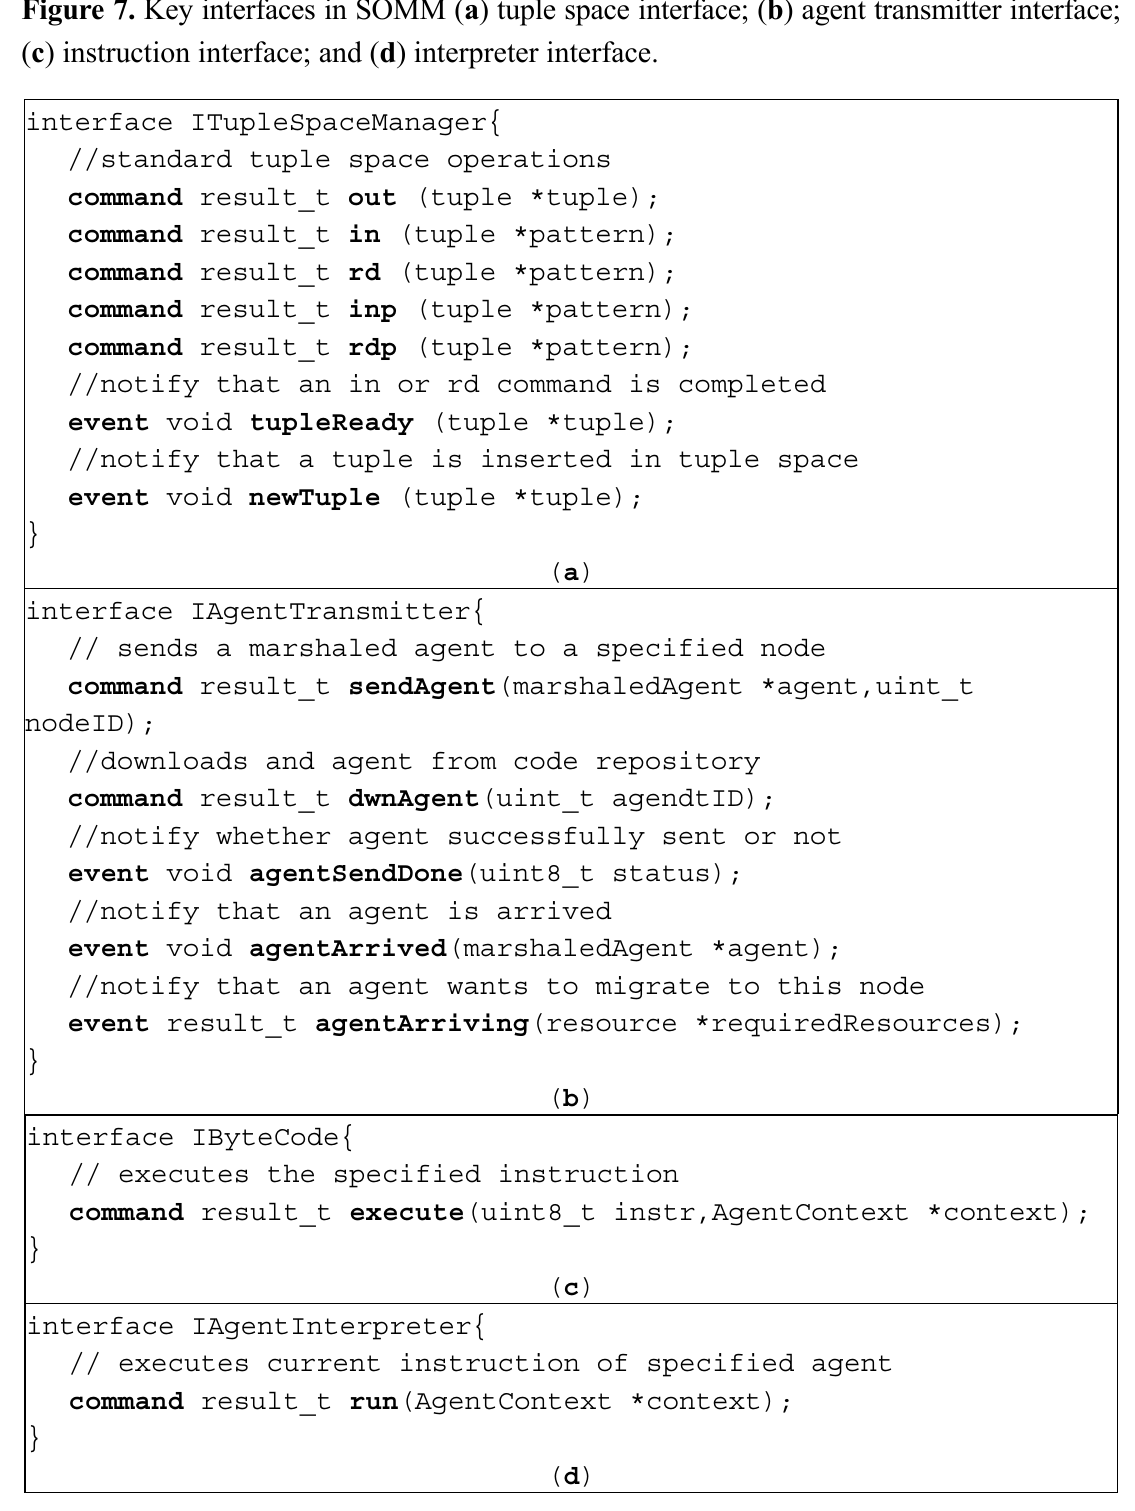
Figure 7. Key interfaces in SOMM ( a ) tuple space interface; ( b ) agent transmitter